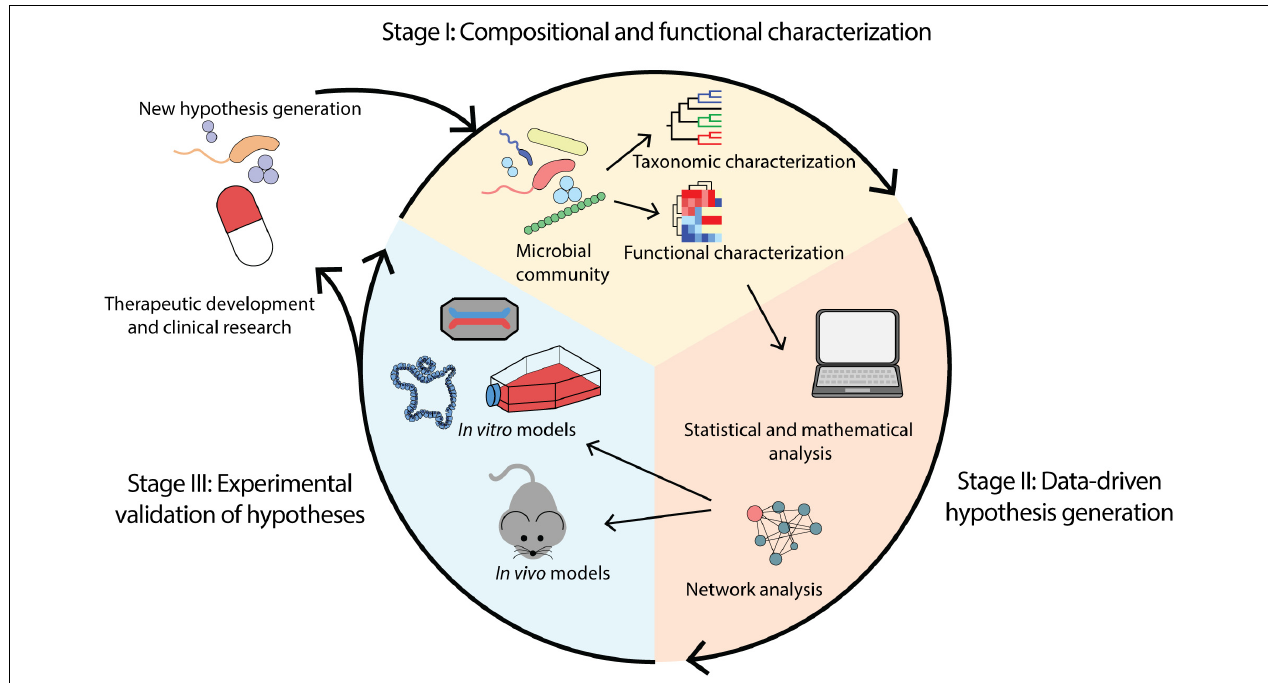
FIGURE 1 | Overview of microbiome analysis workflow for the purpose of determining causality and enabling therapeutic development. (i) Compositional and functional characterization of a microbial community through identification of taxa and functions present. (ii) Data-driven hypothesis generation through application of computational methods including mathematical and statistical modeling. (iii) Experimental validation of hypotheses using in vivo and in vitro models such as animal models, cell lines, organoids and